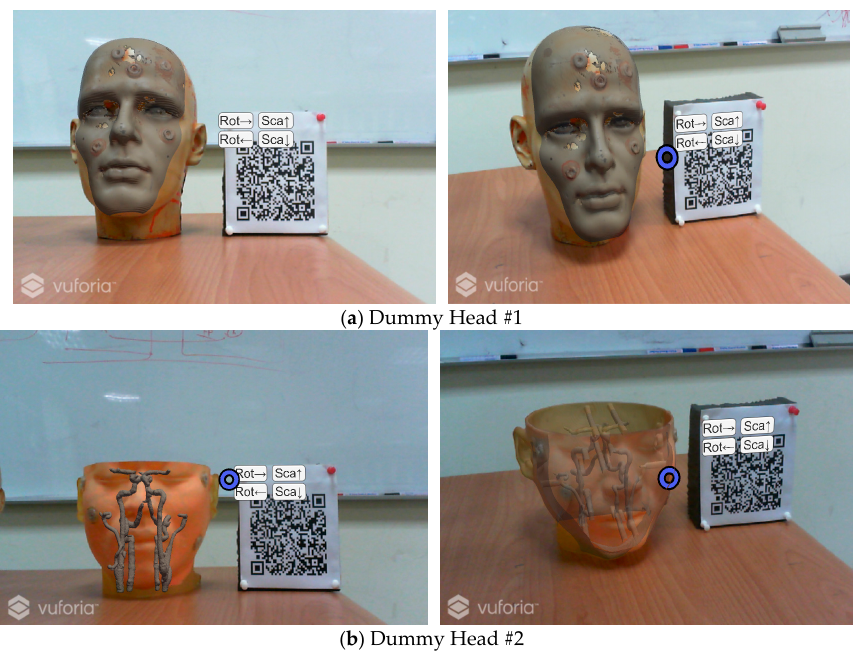
Figure 10. Display of cursor for interactive rotation, and scaling.